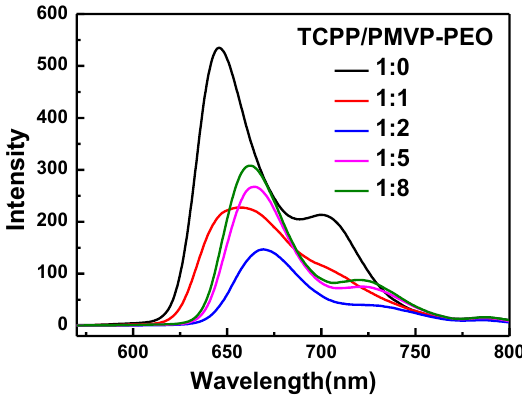
Figure 5. Fluorescence spectra of TCPP (black line) and TCPP/PMVP-PEO with different charge ratios of 1:1 (red line), 1:2 (blue line), 1:5 (pink line) and 1:8 (green line). [TCPP] = 0.02 mM, pH = 10.0, λ ex = 400 nm. PMVP-PEO is an abbreviation of PMVP 41 - b -PEO 205 .